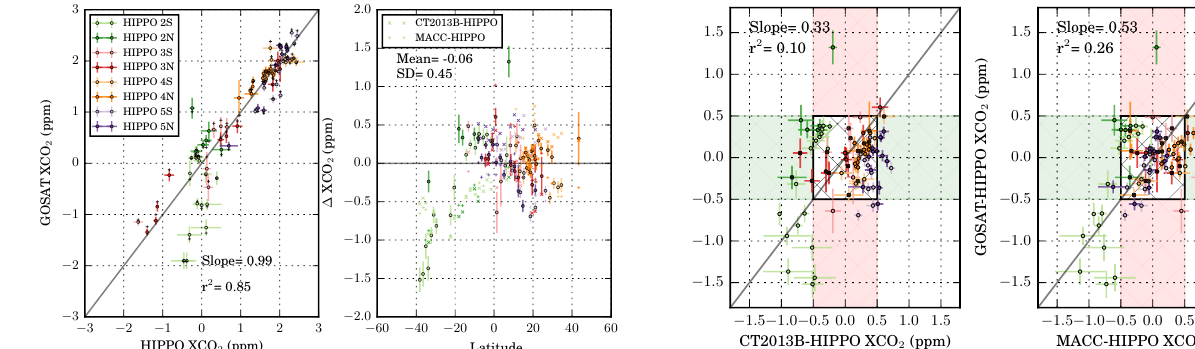
Figure 8. Left: scatter plot of (cid:49) XCO 2 (CT-HIPPO) against (cid:49) XCO 2 (GOSAT–HIPPO), using just the GOSAT subsets. Right: same as left but using MACC instead of CT2013B. The inner box represents the area where both model and GOSAT are within 0.5ppm compared to HIPPO, which corresponds to the very strin- gent accuracy requirement. The green and red shaded areas corre- spond to regions where the satellite deviates less than the models and is within 0.5ppm (green) as well as where the models deviate less than GOSAT (red). The white cells on the outer edges indicate areas where both deviate more than 0.5ppm overall.